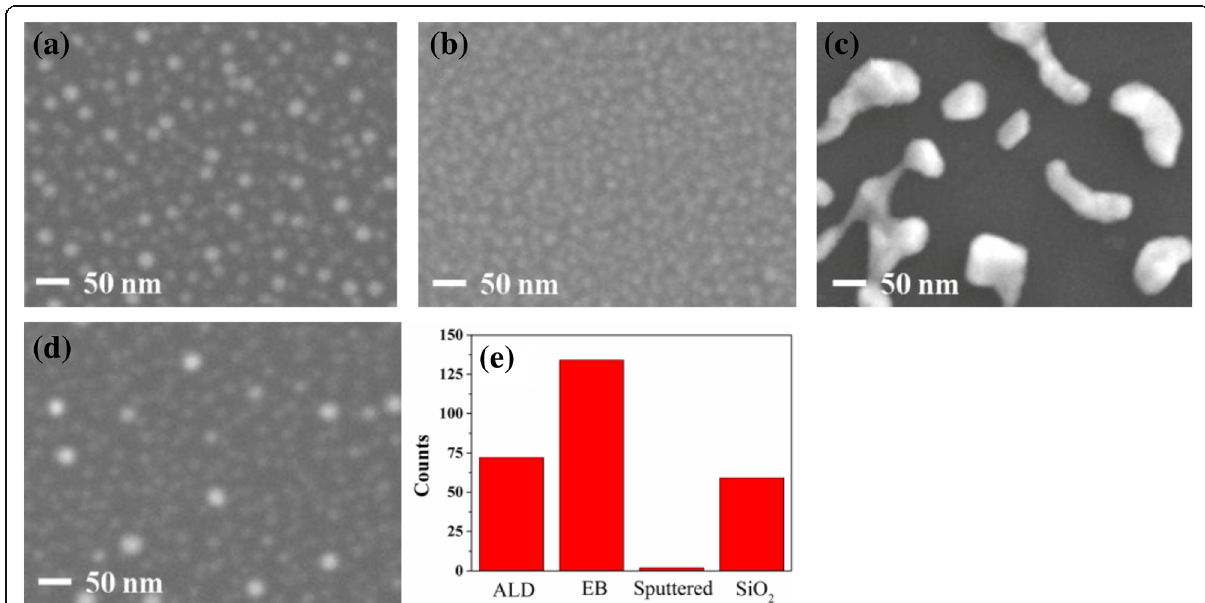
Fig. 4 Plan-view SEM images of catalyst nanoparticles formed on different buffer layers after annealing at 550 °C in the absence of C 2 H 2 : a ALD Al